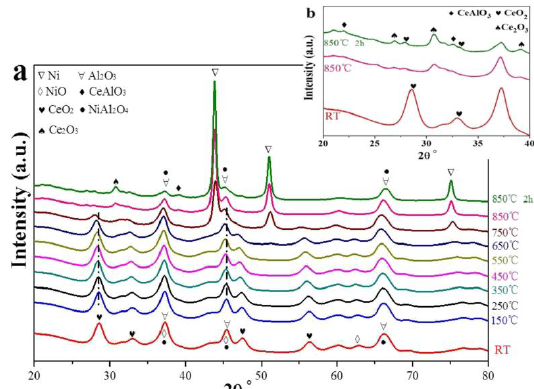
Figure 2. In-situ XRD patterns of 10 wt % Ni/CeO 2 -Al 2 O 3 catalyst ( a ) reduced from room temperature (RT) to 850 °C and kept at 850 °C for 2 h; ( b ) from 20° to 40° at RT, 850 °C and after reduction at 850 °C for 2 h. Reproduced with permission from [18].